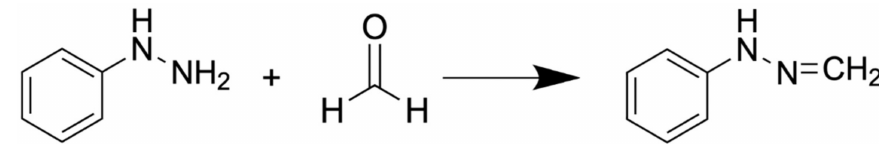
Figure 3. 2,4-dinitrophenylhydrazine reaction with formaldehyde.